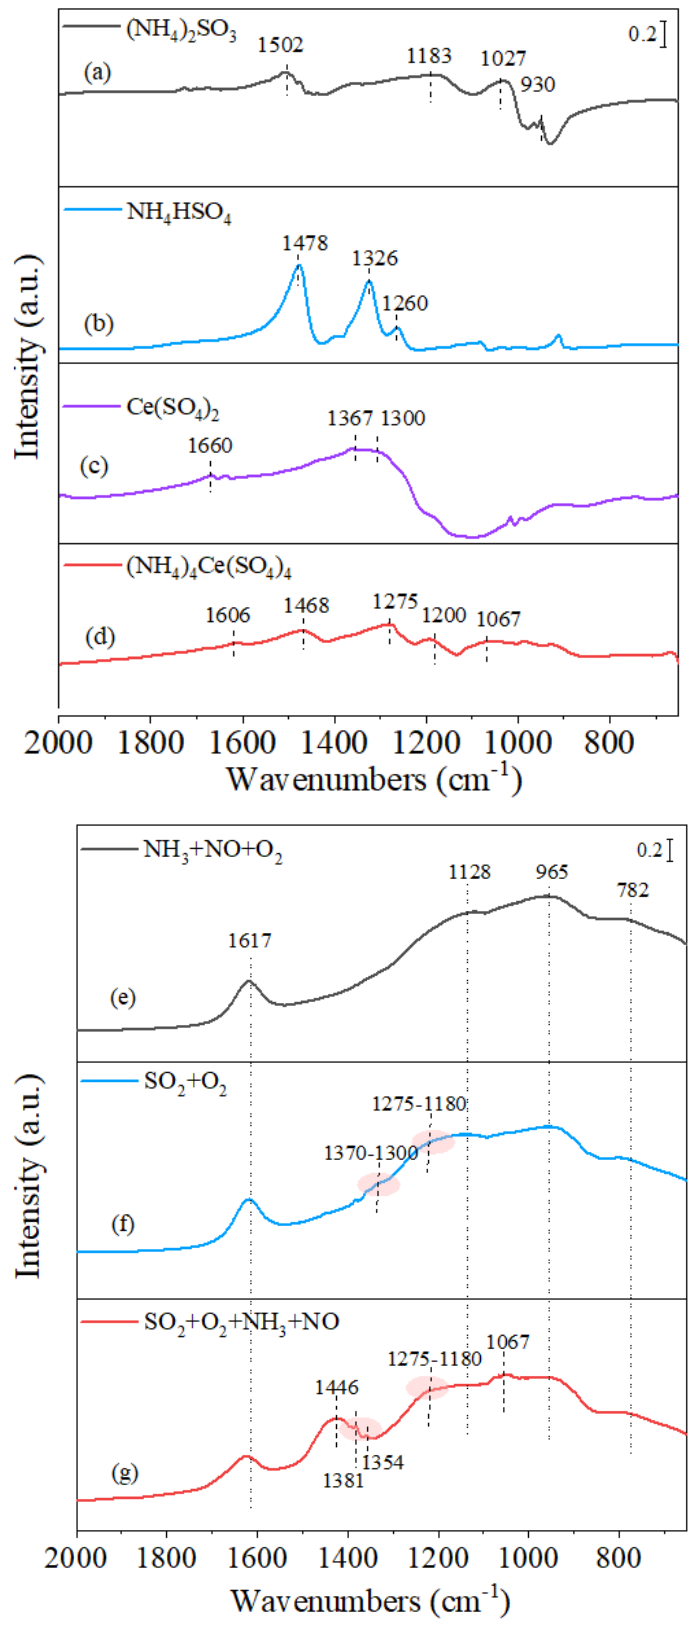
Figure 4. IR spectra of ( a − d ) reference samples and ( e − g ) treated CeNbTi catalysts.